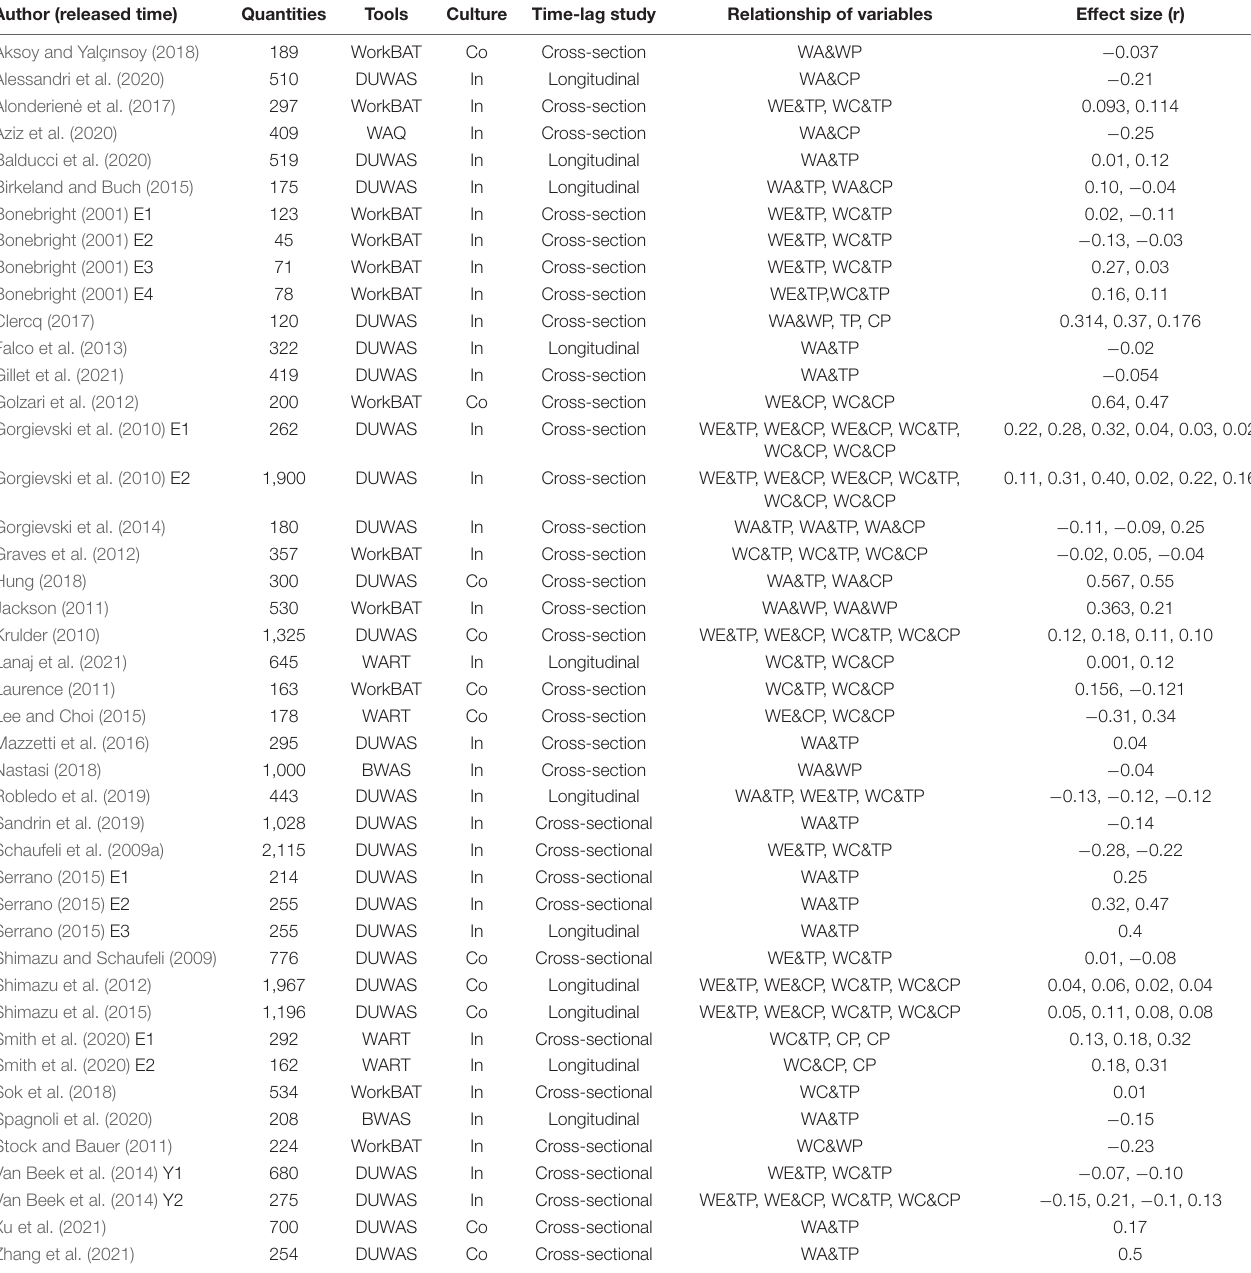
TABLE 1 | Basic data of meta-analysis